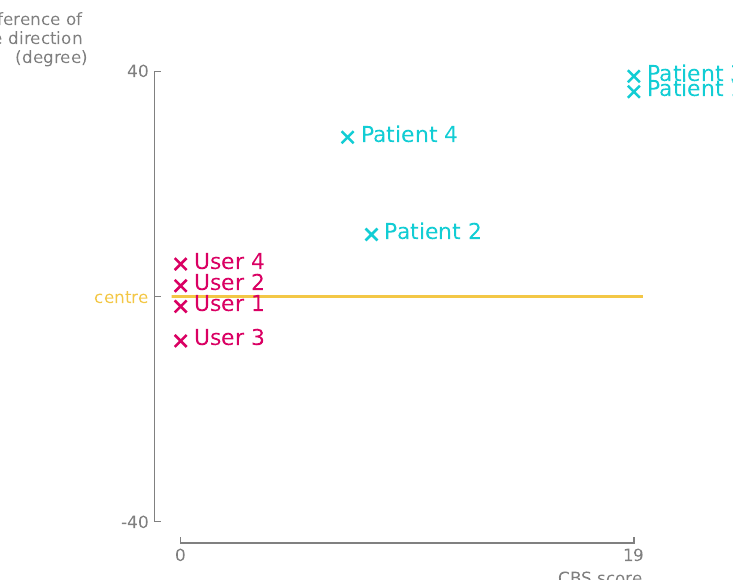
Figure 14. The CBS scores of all participants are plotted against the difference between average head direction during the first 11 s and the remainder of the Assessment . These indicate a linear correlation with a bias towards the neglected side. The higher the CBS score, the greater the bias towards the neglected side of